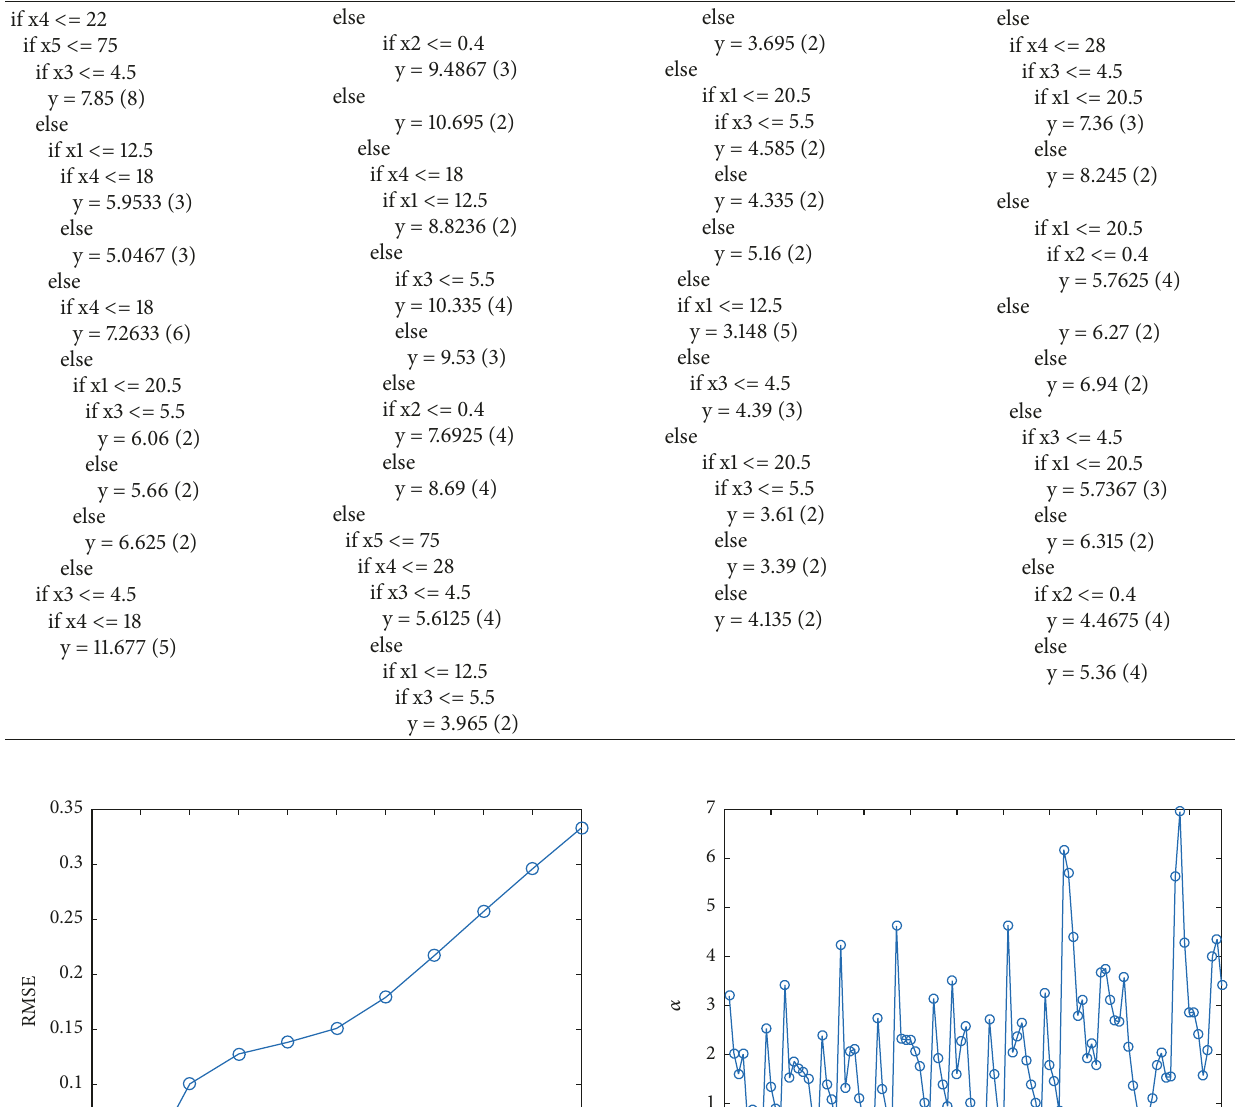
Table 4: Regression tree obtained from M5Tree for settlement modeling.